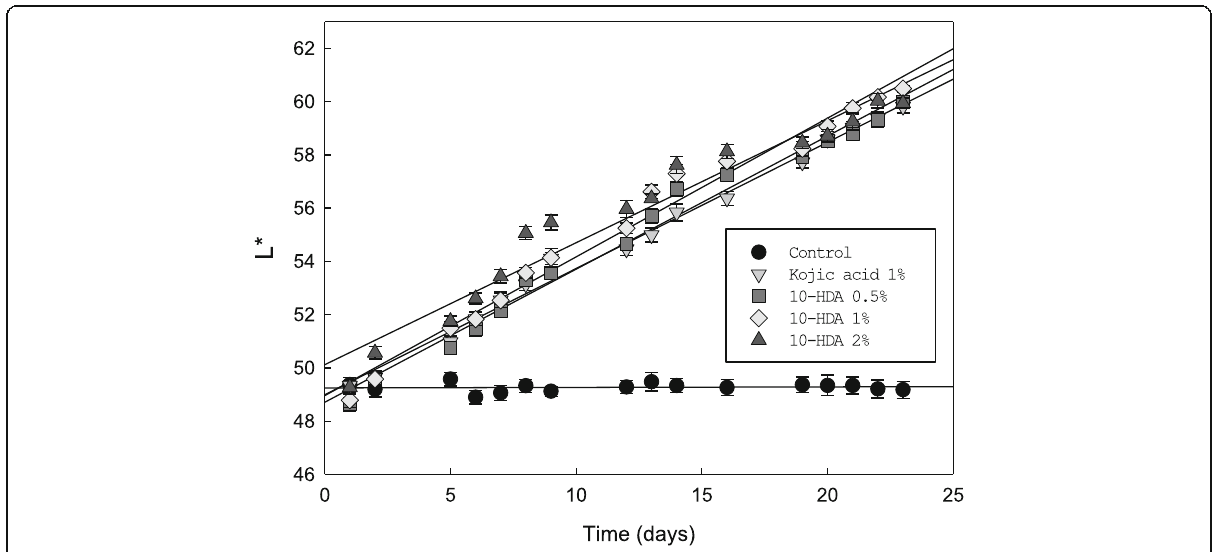
Fig. 5 Time course of skin whitening index (L value) of mice treated with Vaseline only (control, ), 1% Kojic acid in Vaseline ( ), 2% 10-HDA ( ), 1% 10-HDA ( ) or 0.5% 10-HDA ( ) in Vaseline. A total of forty mice were equally divided into five groups, and each group was smeared twice daily in 5 consecutive days a week for 3 weeks with 0.1 g Vaseline (control, ), 1.5% Kojic acid in Vaseline ( ), 2% 10-HDA ( ), 1% 10-HDA ( ) or 0.5% 10-HDA ( ) in Vaseline. The L value was measured once a day on the same skin area with a DermaLab® Combo. Averaged L values ( n = 8) with an error bar of SD are plotted over the experimental